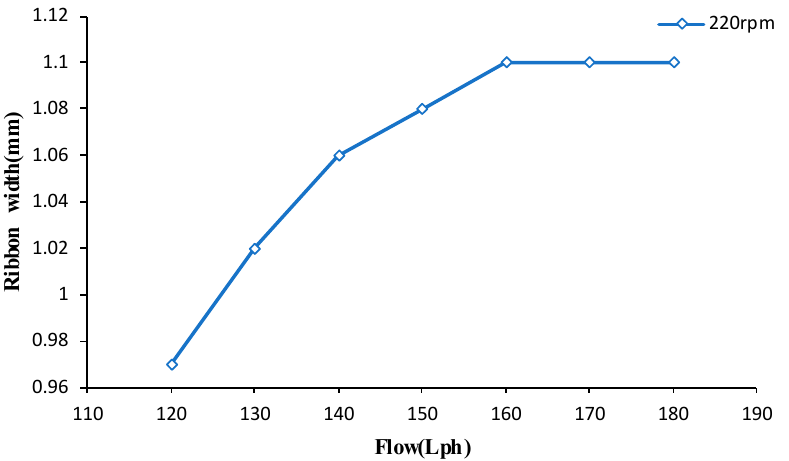
Figure 12. The variation of ribbon width with flow rate.